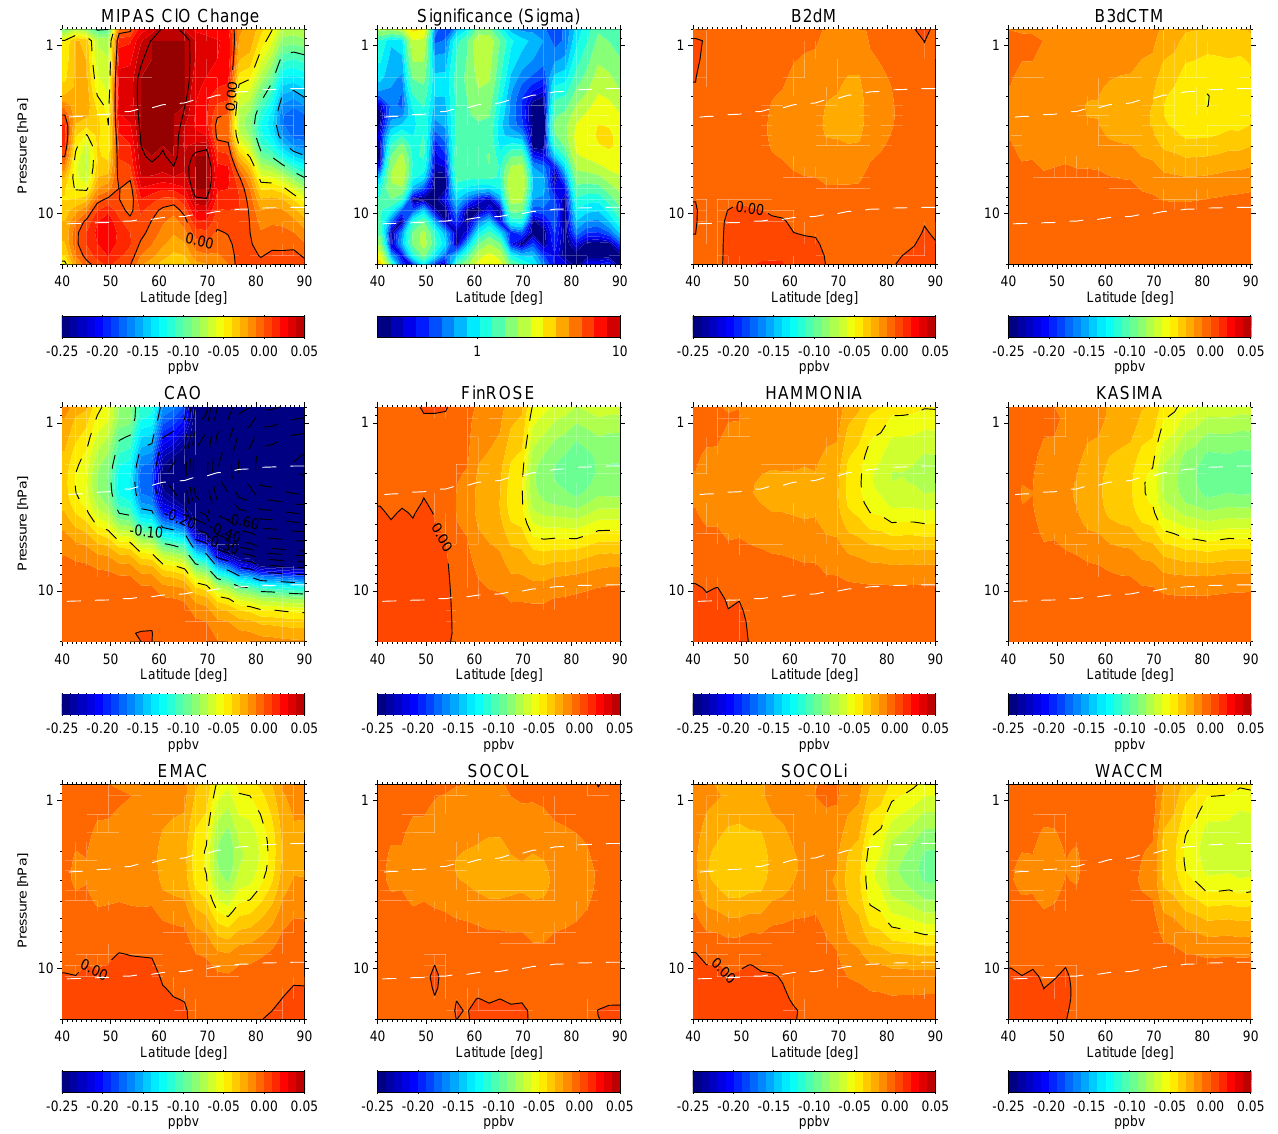
Fig. 32. Zonal mean ClO changes during the main proton forcing (29–31 October) with respect to 26–27 October in MIPAS observations and model simulations. Solid contour lines reflect 0.05 ppbv steps. The significance of observed ClO changes (in units of σ ) is shown in the upper second panel (from the left).